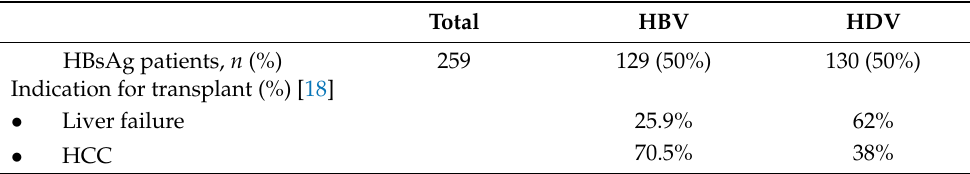
Table 3. HBsAg liver transplants from 2010 to 2019 in Torino, Italy. Total HBV HDV HBsAg patients, n (%) 259 129 (50%) 130 (50%) Indication for transplant (%) [18]